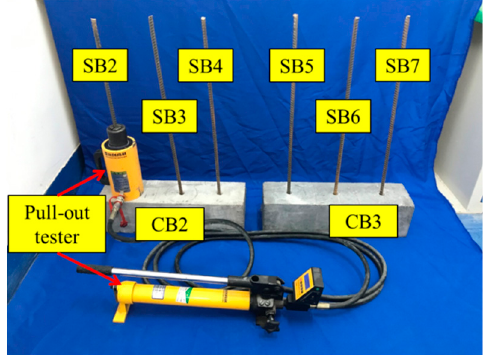
Figure 7. Experimental setup of the pull-out test